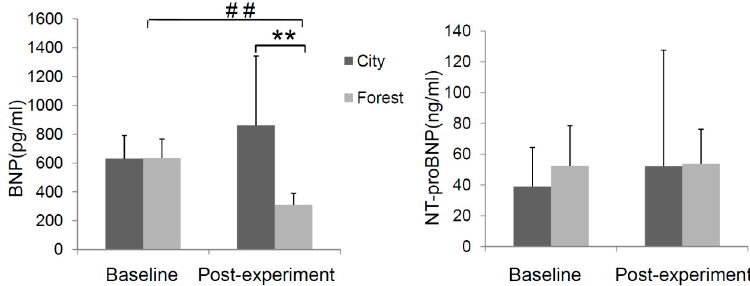
Figure 3. Effect of forest bathing on change of CHF biomarkers including brain natriuretic peptide (BNP) and NT-proBNP in the experimental subjects (forest group ( n = 23) and control group ( n = 10)). ** p < 0.01; ## p < 0.01, analyzed by the Kruskal-Wallis test, followed by the Dunn-Bonferroni test.